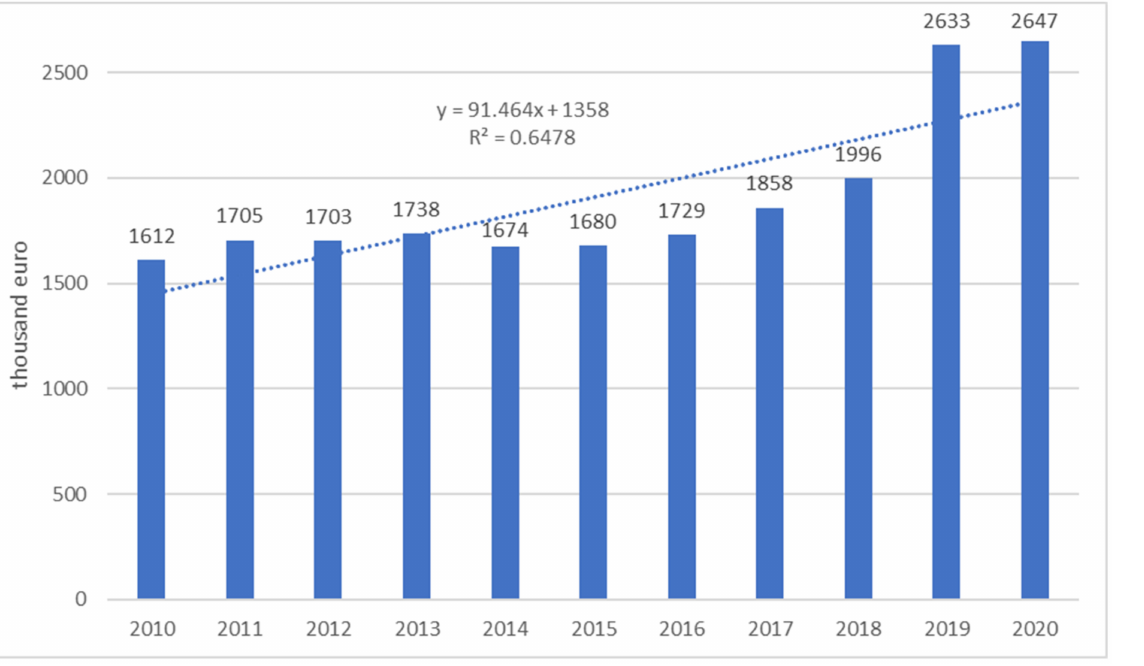
Figure 4. 2010–2020 spending on the PRVT